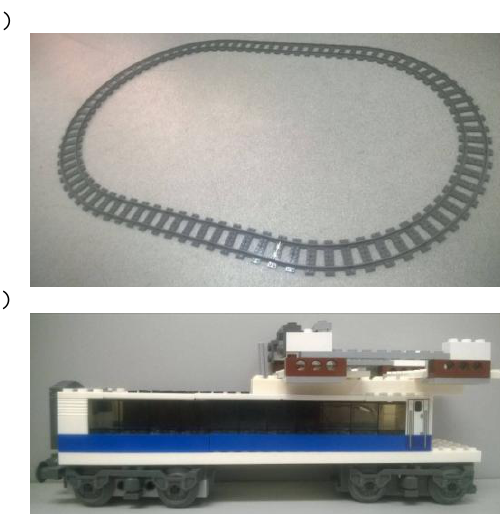
Figure 4. (A) Railway model. (B) Motorised model train.